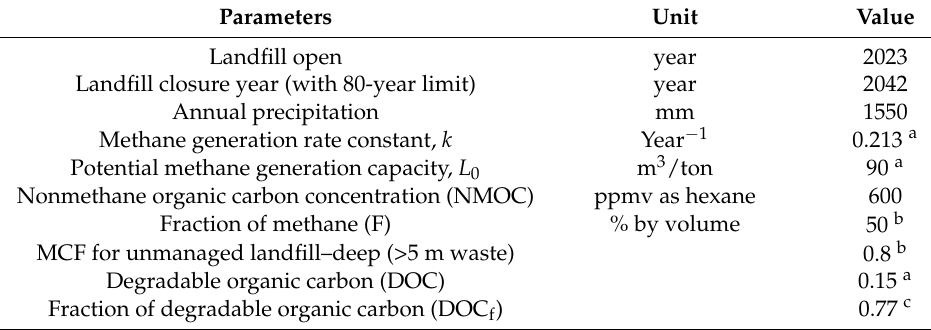
Table 4. Key parameters for the LandGEM model.